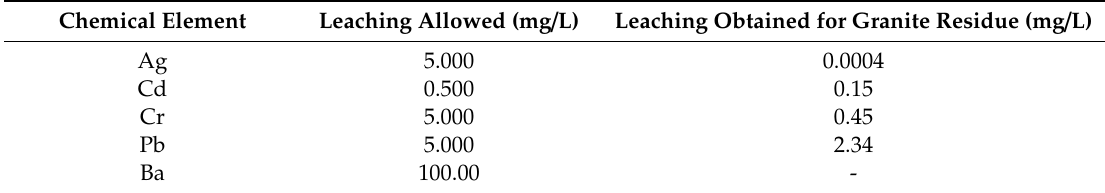
Table 3. Leaching test conditions and results for the granite